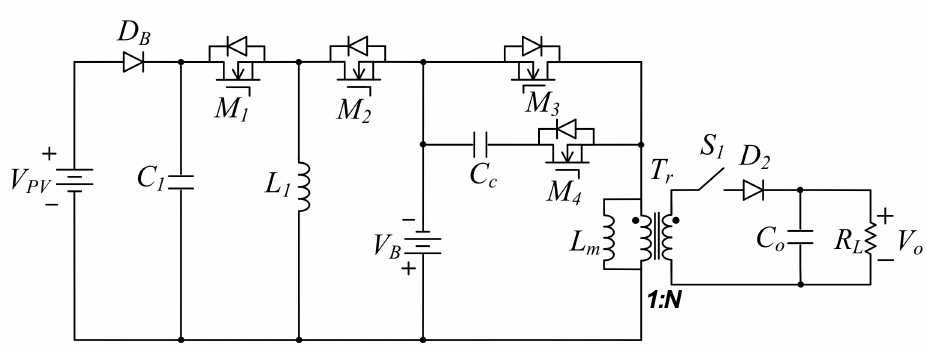
Figure 6. Schematic diagram of the convention bidirectional buck-boost/flyback hybrid converter for solar power applications.